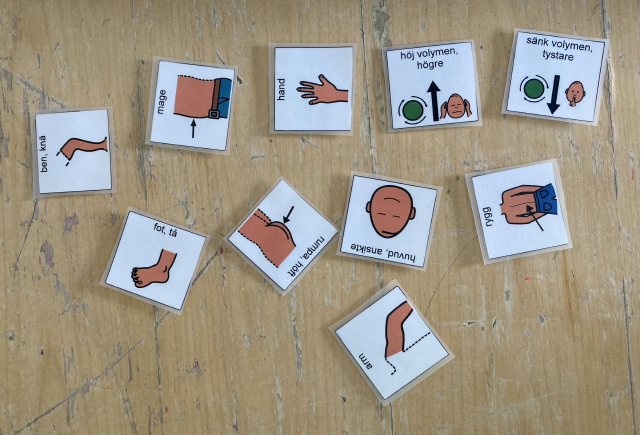
Figure 4. PODD pictures used to describe haptic sensations (body locations and intensity of a vibration): leg, knee; belly; hand; raise the volume, louder; lower the volume, softer; foot, toe; bottom, hip; head, face; back;